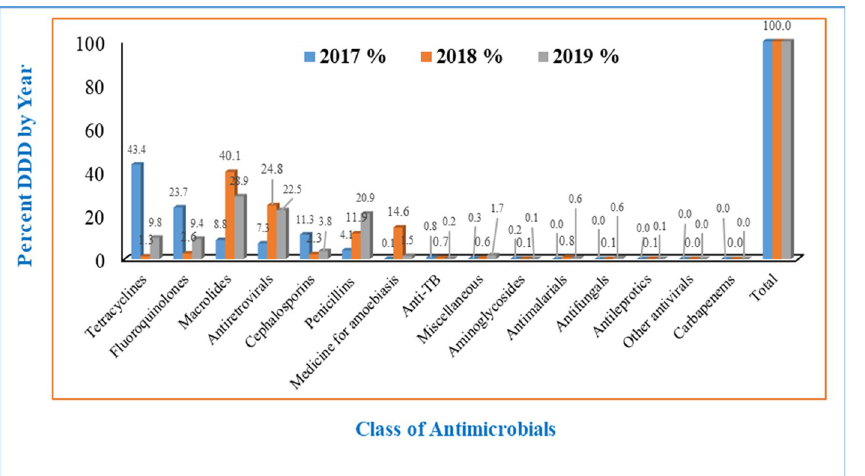
Fig 2. Antimicrobial consumption by year and anatomical therapeutic chemical level.